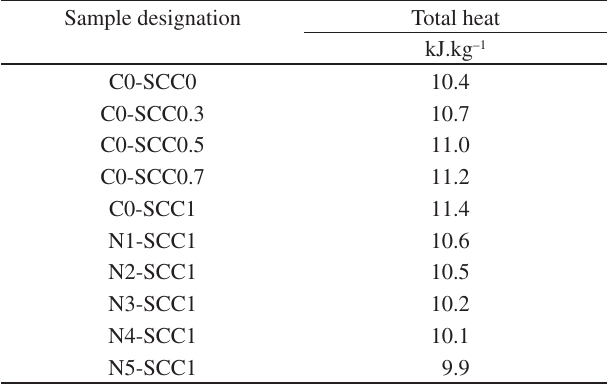
Table 7. Weight loss (%) of the pastes in the range of 110-650 °C at 28 days of curing of C0-SCC and N-SCC specimens. Sample